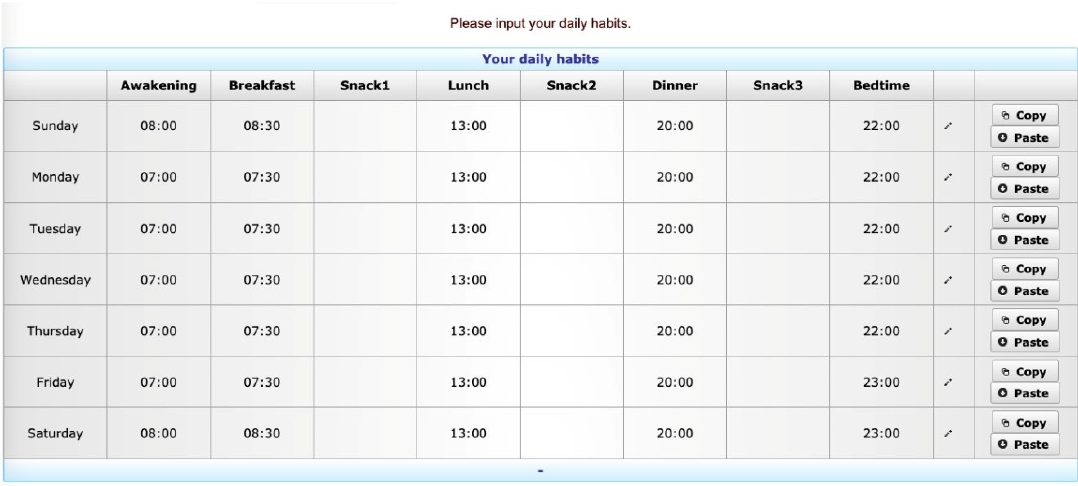
Figure 2. Form to provide, for each day of the week, patient’s usual time schedule concerning daily habits.